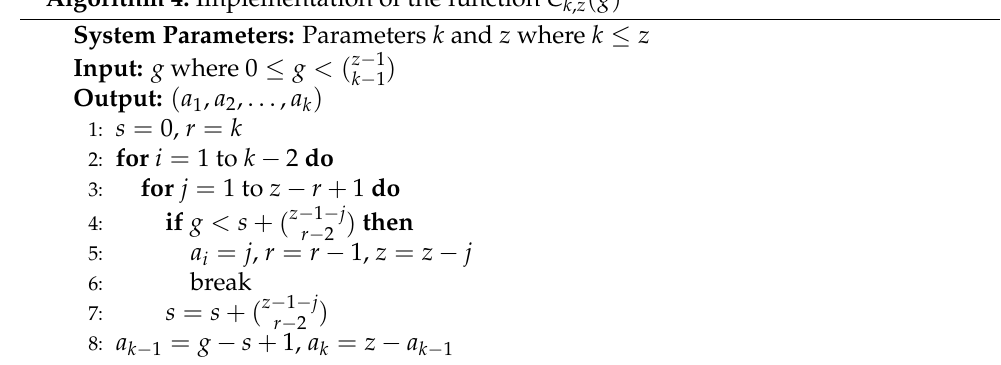
Algorithm 4: Implementation of the function C k , z ( g